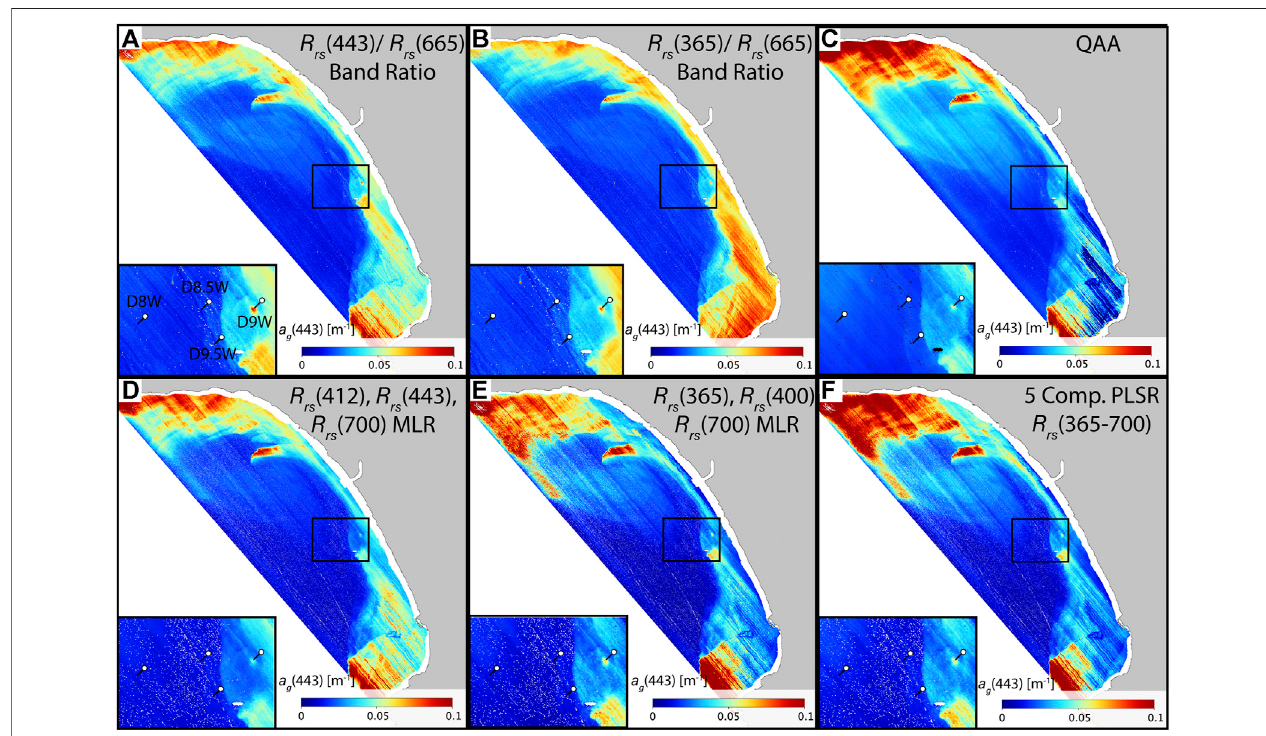
FIGURE 10 | Maps of a g ( 443 ) retrieved from the PRISM R rs ( λ ) using the QAA and the empirical algorithms developed in this study. The a g ( 443 ) retrievals were made using the following algorithms: (A) blue-red band ratio R rs (443)/ R rs (665), (B) UV-red band ratio R rs (365)/ R rs (665), (C) QAA algorithm v.6, (D) visible-only multiple linear regression (MLR) on R rs (412), R rs (443), R rs (700); (E) UV-visible MLR on R rs (365), R rs (400), R rs (700), and (F) partial-least-square regression (PLSR) on the full spectrum R rs (365 – 700) using the fi rst fi ve components.